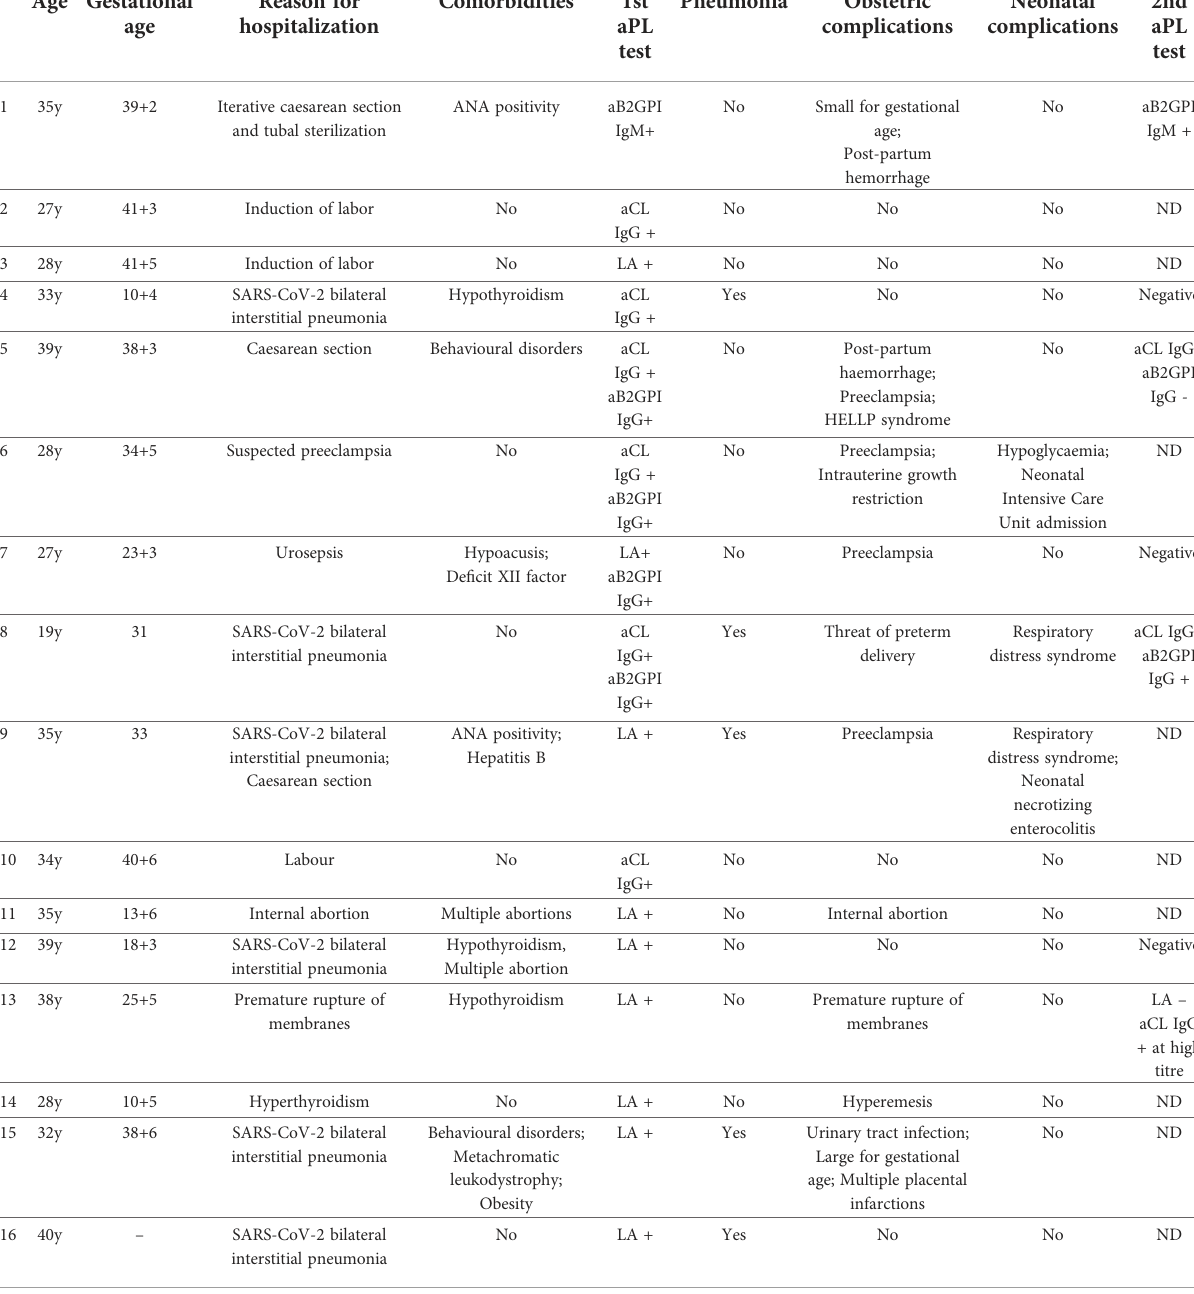
TABLE 4 Description of the 16 patients who resulted positive for antiphospholipid antibodies